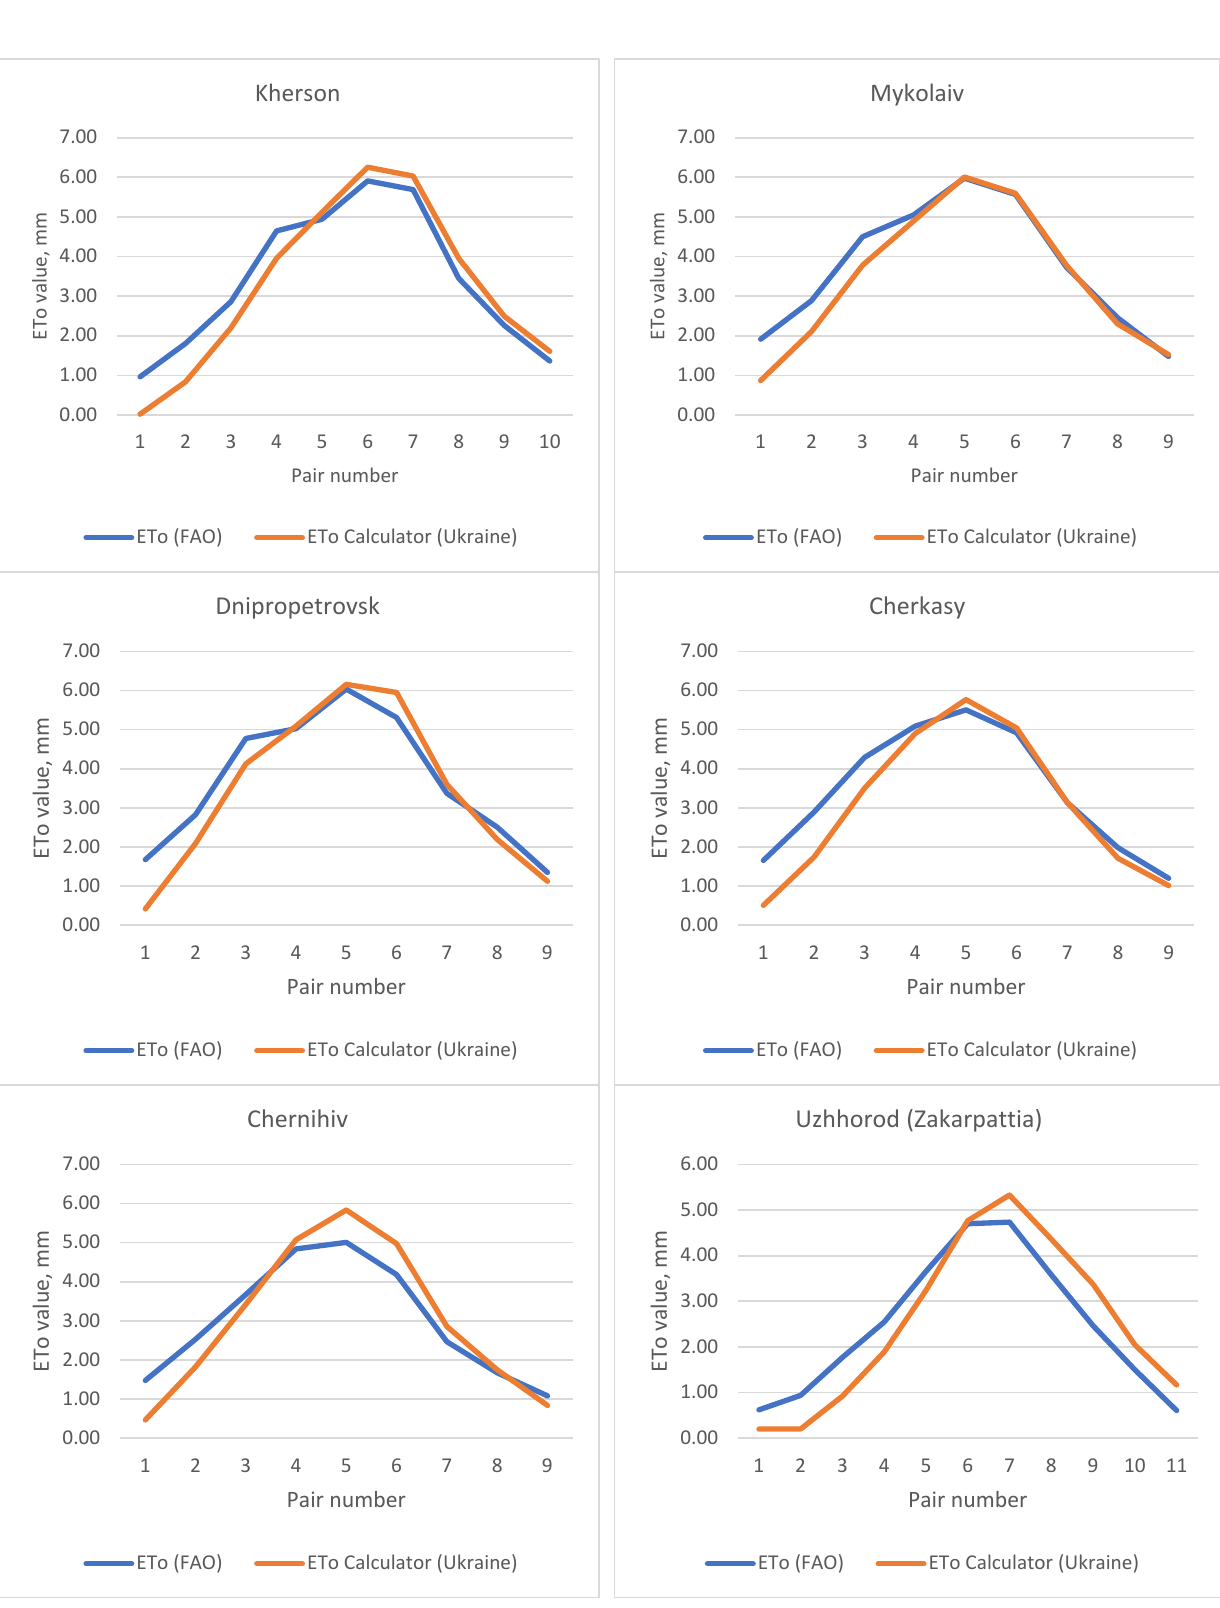
Figure 3. Reference evapotranspiration (mm/day) comparison between the standard FAO Penman– Monteith (Sherzod Rusmetov adaptation) and ETo Calculator (Ukraine) method by the studied regions of Ukraine (monthly scale comparison).